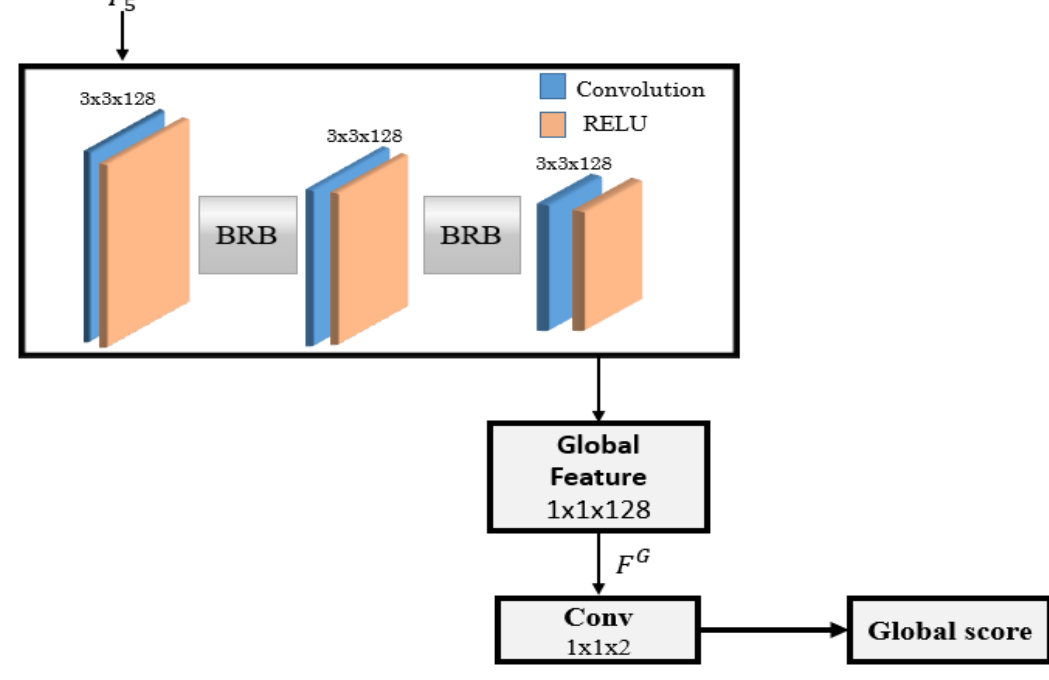
Figure 3. Extraction of global features. Feature map from fifth convolutional layer was used, passed through dilated convolutions. For maintaining spatial information, boundary-refinement blocks (BRBs) were also